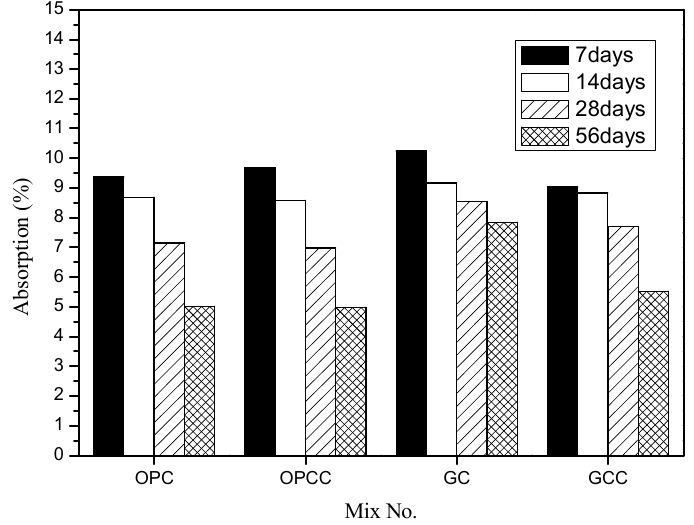
Figure 6. Comparison of absorption of concrete.